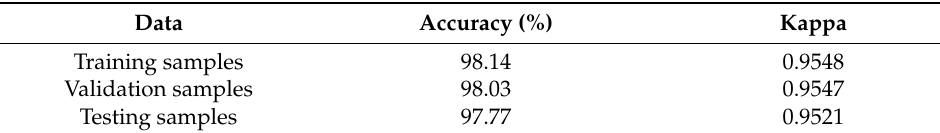
Table 2. Accuracy results of different sample datasets.